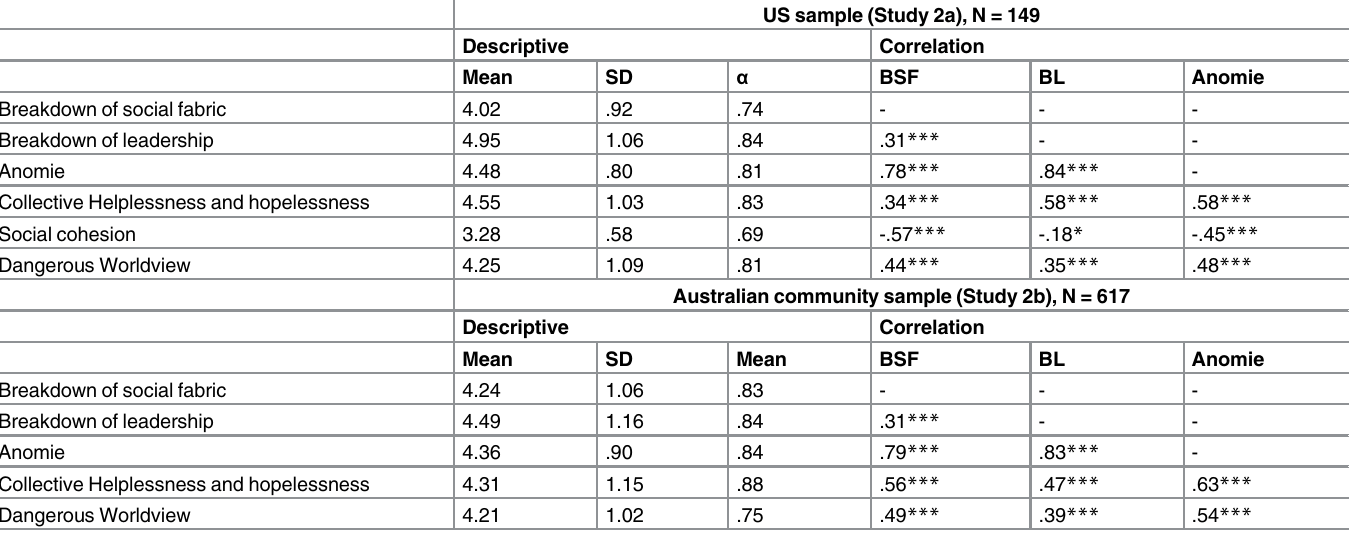
Table 2. Descriptives and bivariate